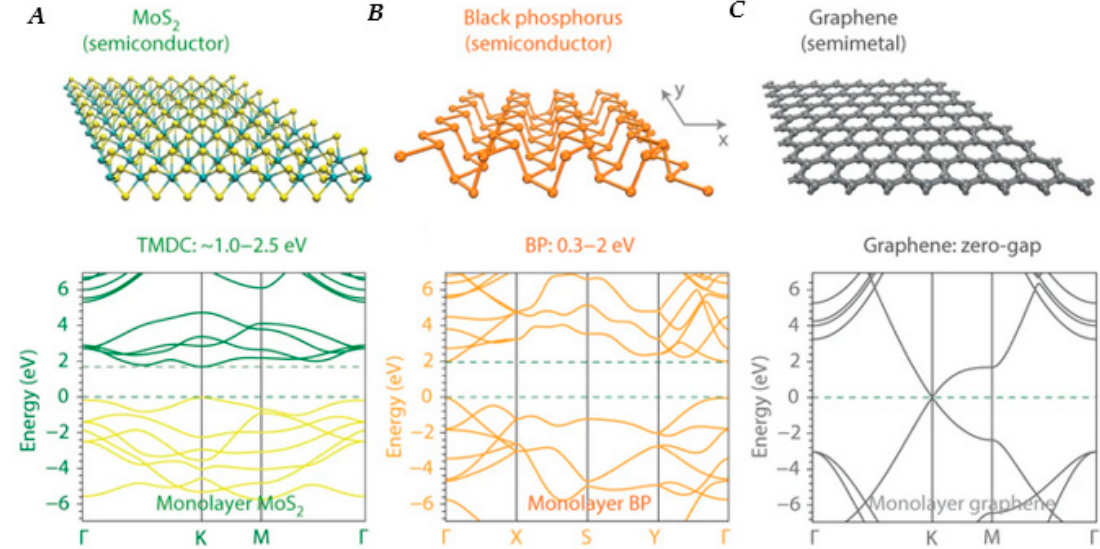
Figure 2. Single-layer atomic structure (top) and band structure (bottom) of selected 2D layered materials of interest. ( A ) Moleybdenum disulfide (MoS 2 ). ( B ) Phosphorene (black phosphorous). ( C ) Graphene. Figure ( A – C ) Reproduced with permission from [72]. Copyright Springer Nature, 2014.